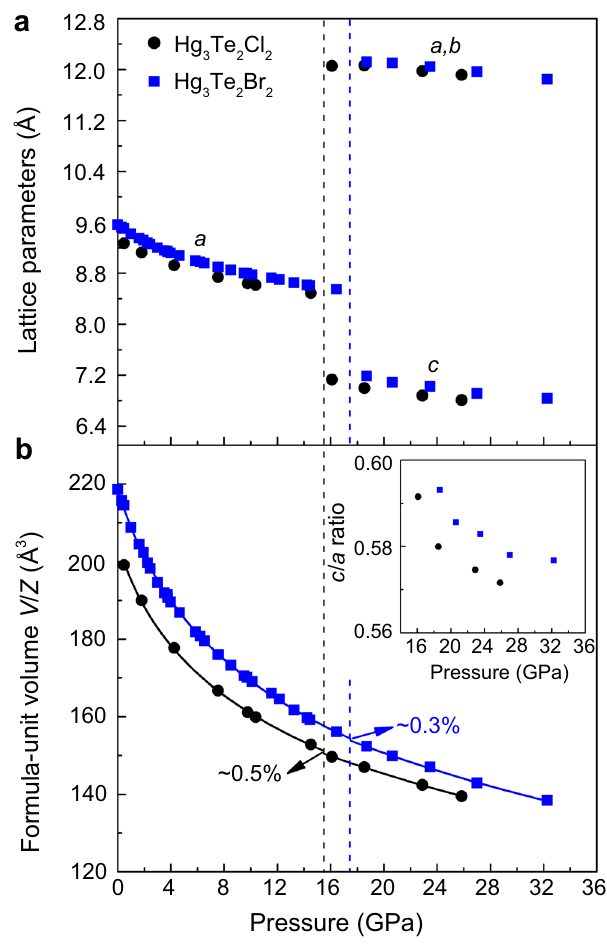
Fig. 1 Lattice parameters of Hg 3 Te 2 X 2 compressed in helium at room temperature. a Lattice parameters a , b , and c as a function of pressure obtained from single-crystal X-ray diffraction. b The third- and second-order Birch – Murnaghan equations of states (EOS) fi t to the formula-unit volume ( V / Z ) data. These EOS have been used for calculating the Δ V collapse at the phase transition between phases I and II. The calculated bulk moduli are given in Supplementary Table 1. The inset in b indicates the c / a ratio of phase II in both compounds. Vertical black and blue dashed lines indicate phase transitions at 15.5 and 17.5 GPa for X = Cl and Br, respectively. The error bars are smaller than the symbols used in both a and b